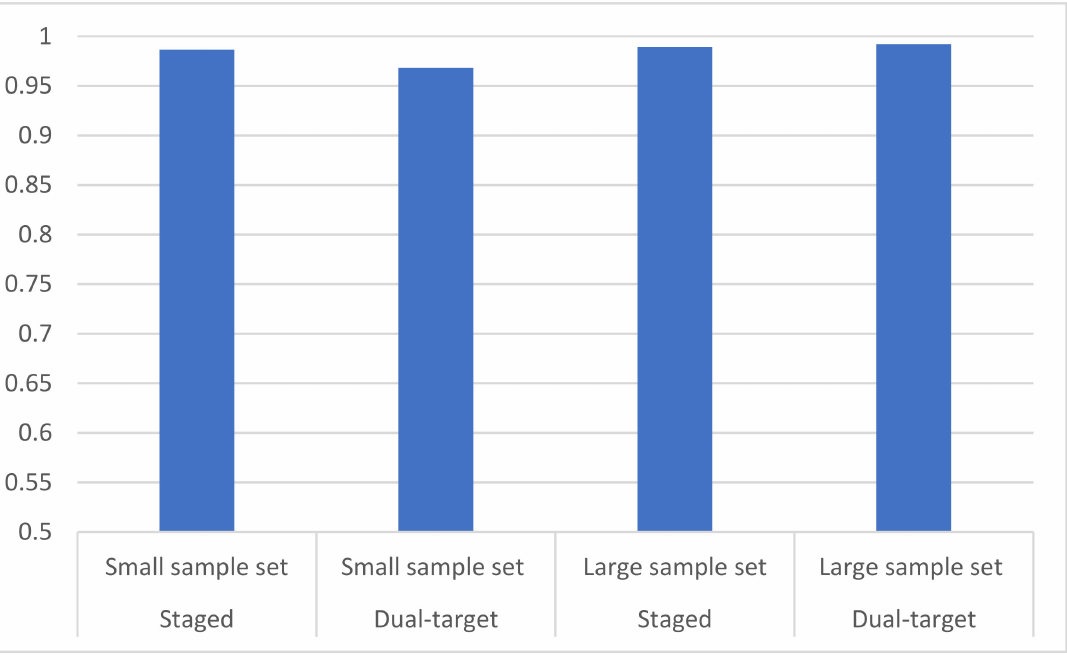
Figure 15. Comparison of the classification accuracy of the staged detection classification method and dual-target detection classification